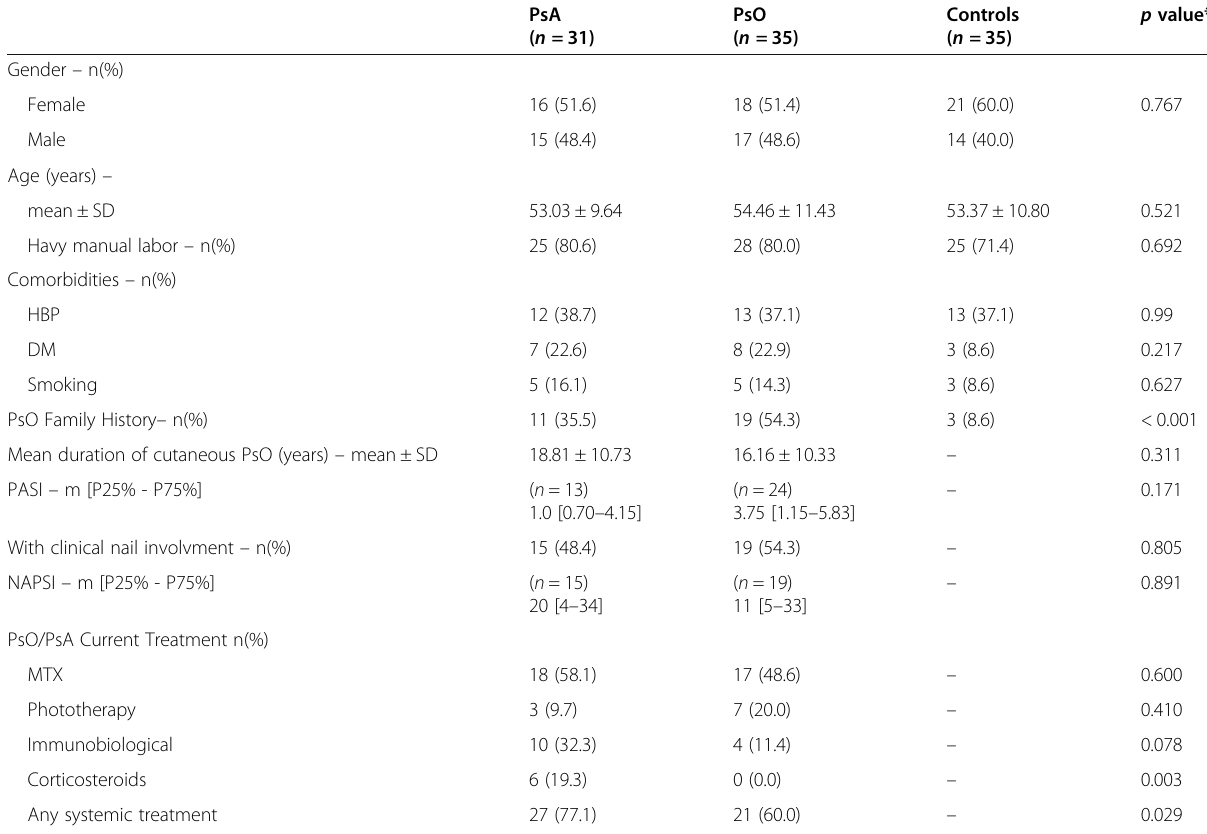
Table 1 Demographic and Disease characteristics in each group